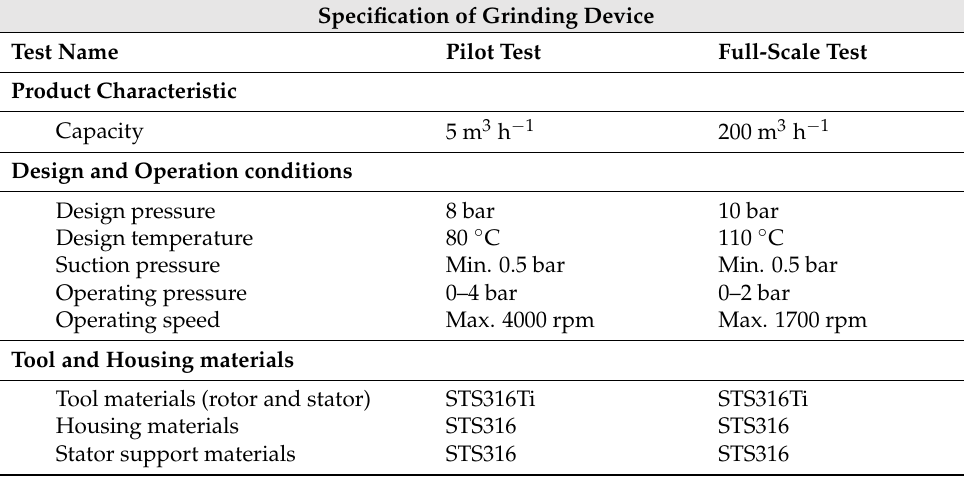
Table 1. Grinding device specification used in pilot test and full-scale